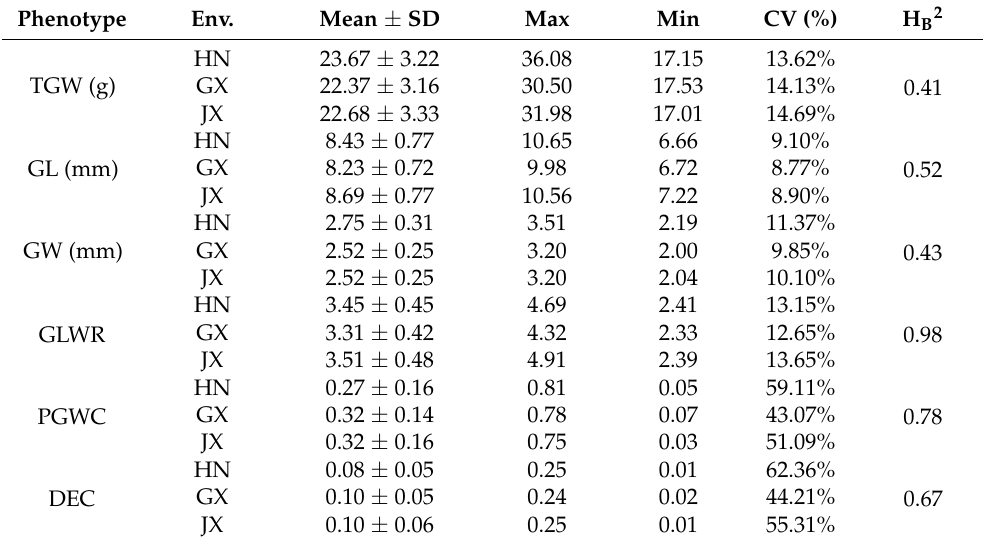
Table 1. Statistics of TGW, GL, GW, GLWR, PGWC and DEC in different